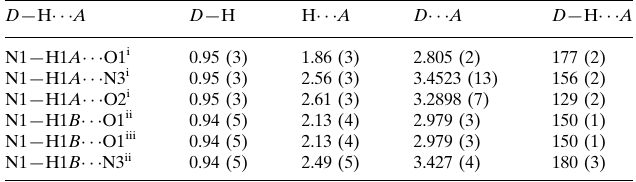
Hydrogen-bond geometry (A˚ , (cid:4)